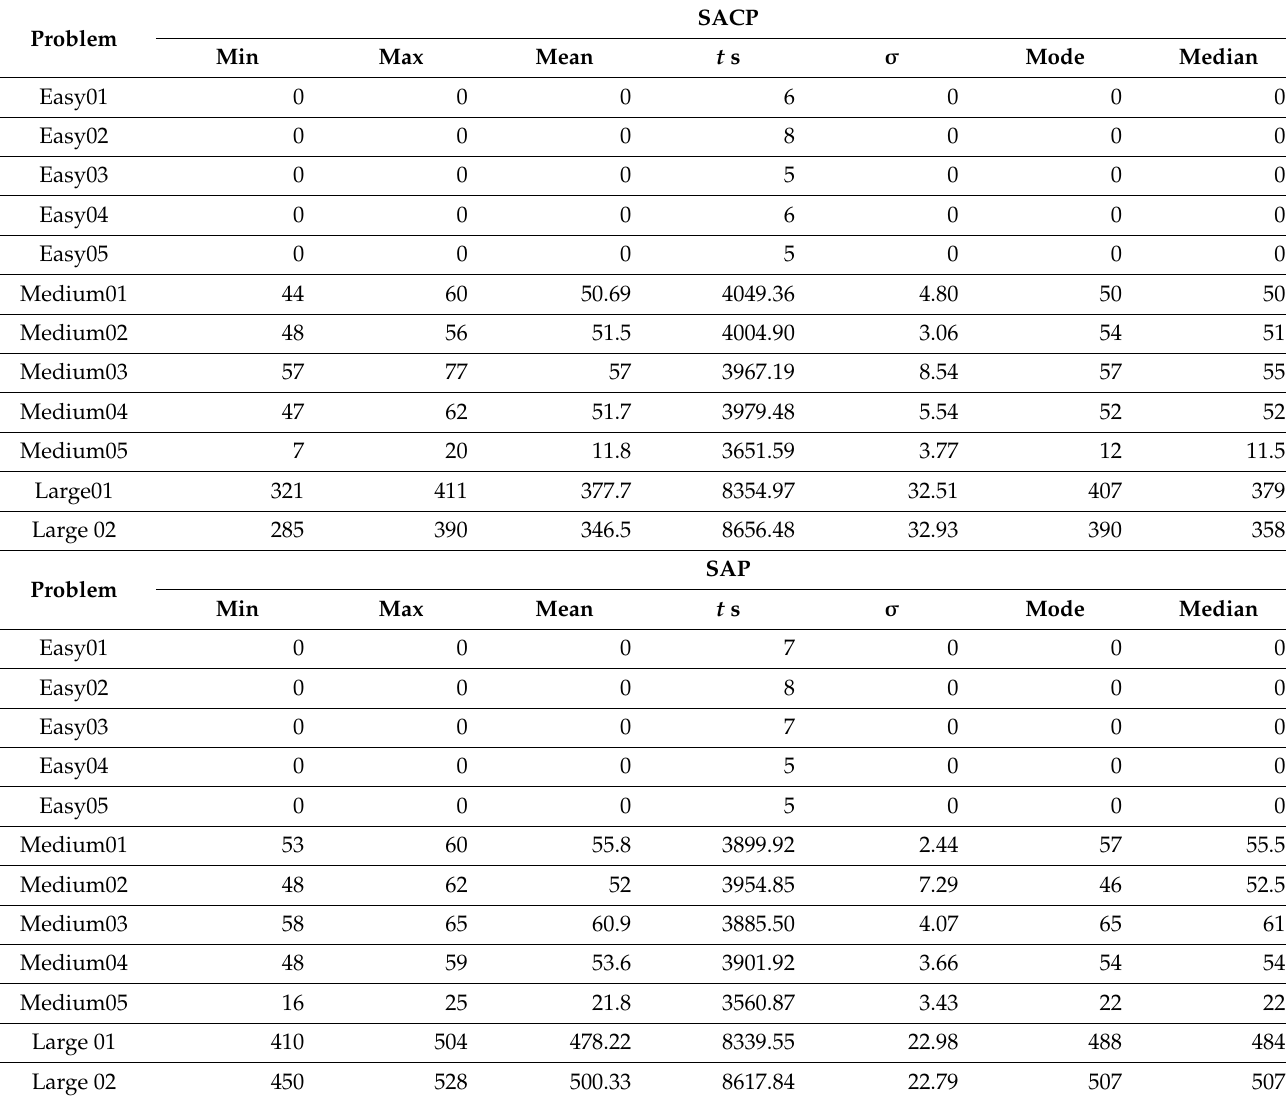
Table 4. Results of simulated annealing metaheuristic with cooperation of processes (SACP) and simulated annealing metaheuristic with processes (SAP) but without